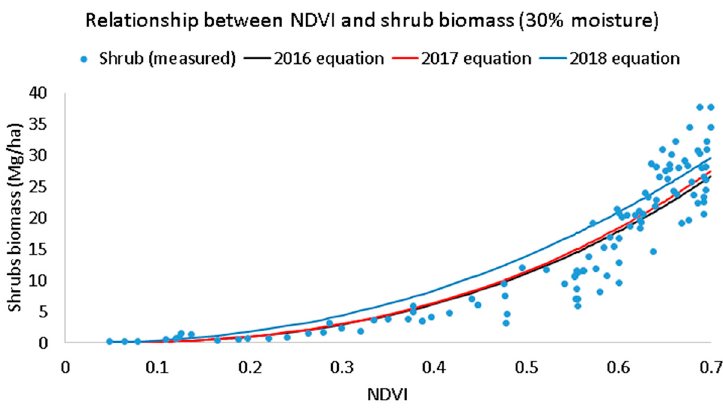
Figure 11. Relationship between NDVI and shrubs biomass estimates.